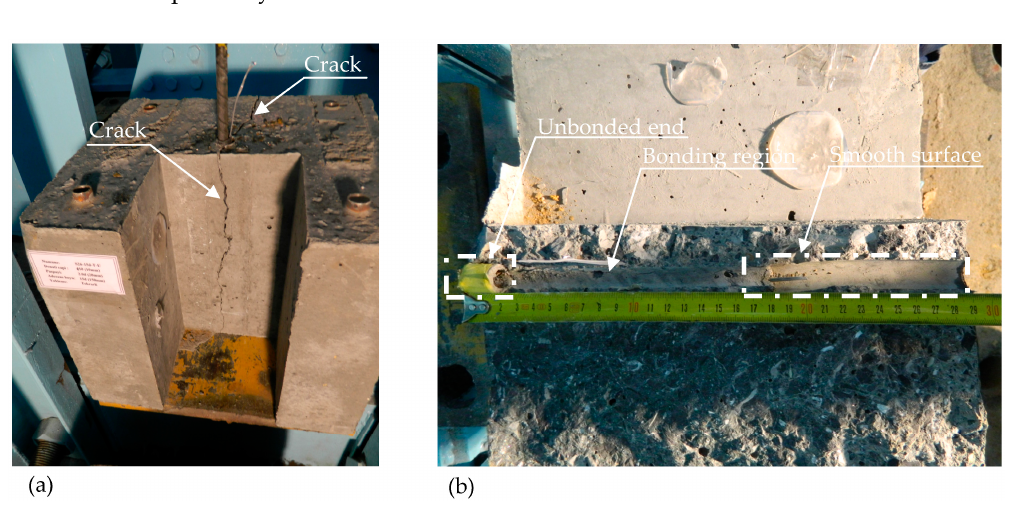
Figure 9. ( a ) Splitting failure; ( b ) Section of bonded and unbonded regions.